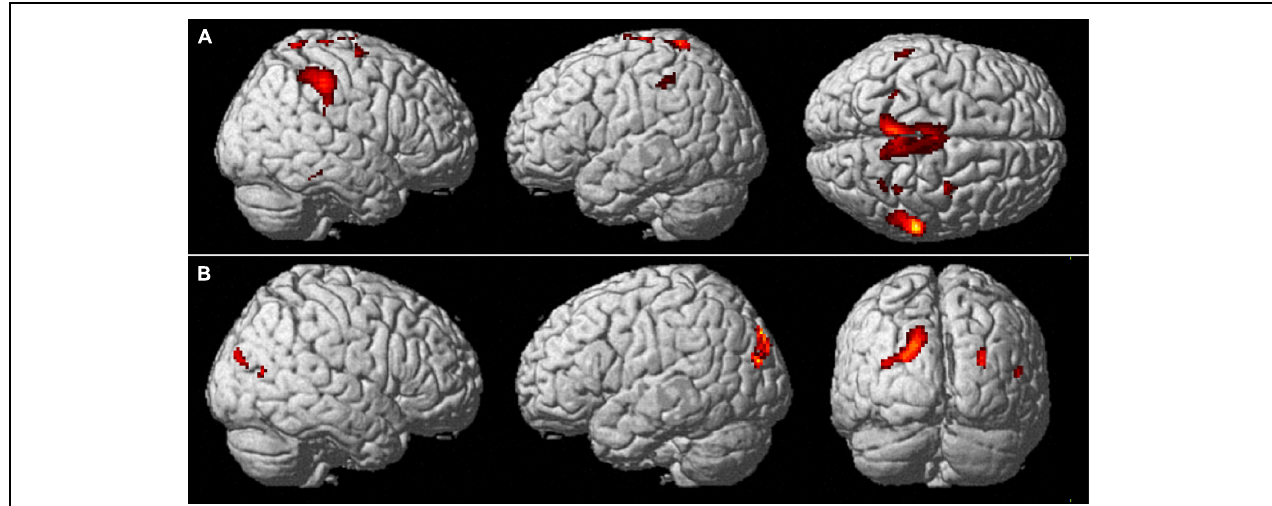
FIGURE 4 | Common brain activations from conjunction null analysis. (A) Upper row: Activations common to walking observation and execution ( p < 0.001, uncorrected, k = 10). Activity is superimposed on a rendered brain viewed from the right (left panel), the left (middle panel), and the top (right panel). (B) Lower row: Activations specifically related to the processing of a narrow space as compared to an open one ( p < 0.001 uncorrected, k = 10). Activity is superimposed on a rendered brain viewed from the right (left panel), the left (middle panel), and the posterior (left